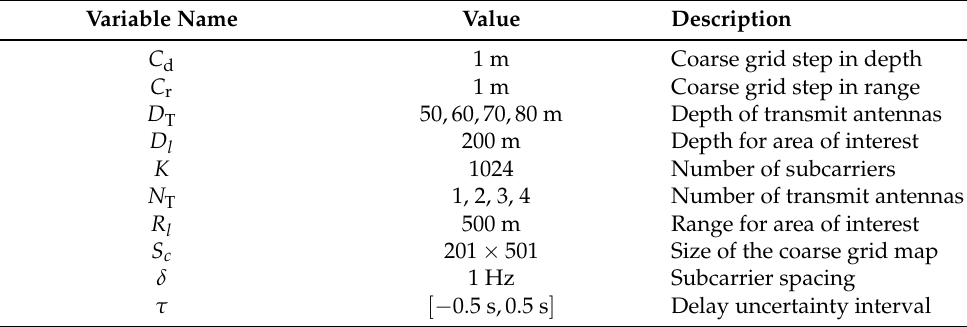
Table 2. Parameters for coarse receiver